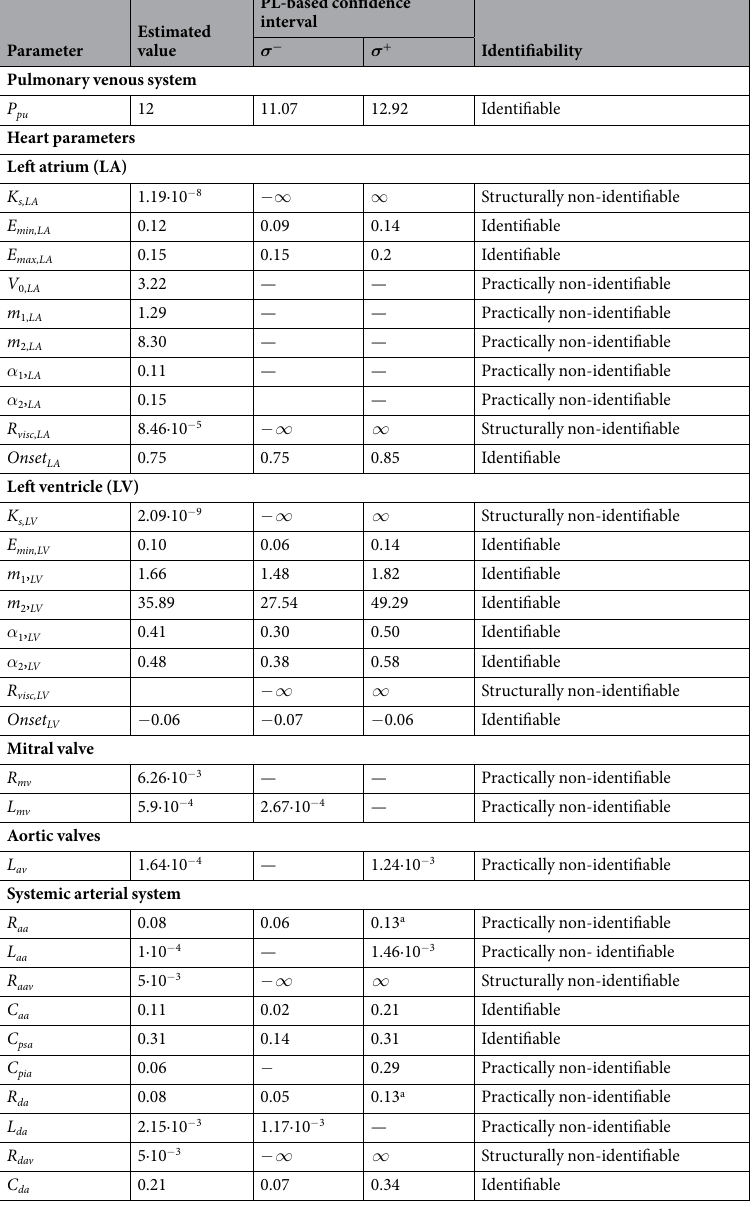
Table 4. Estimated parameter values and the associated 95% confidence intervals [ σ − , σ + ] derived from the profile likelihood for subject 1. a The confidence boundary is computed outside the parameter boundary used in the optimization. Empty confidence boundaries in one (or both) directions indicate that no crosses with the threshold were found within the parameter boundaries used for the optimization. Parameters with a confidence interval [ − ∞ , ∞ ] had a flat profile likelihood for any arbitrary value of the